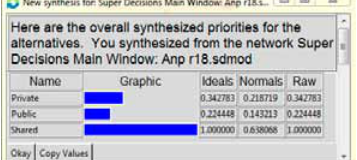
Table 10. Limited super matrix for Interest rates (r